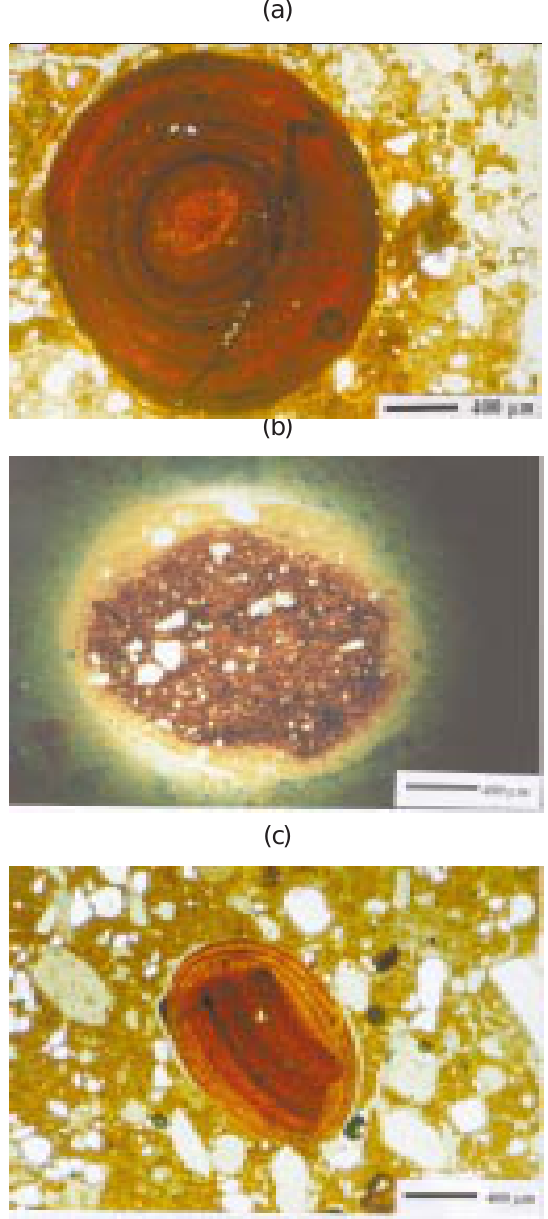
Figura 4. Concreção observada no horizonte BC2 do Cambissolo. Observa-se o aporte de ferro ao redor da estrutura (A), nódulo sesquioxídico do Bi3 do Cambissolo, onde se observam diferentes graus de hidratação dos óxidos de ferro (B), concreção ferro-manganosa da camada de 15-30 cm de um Latossolo Vermelho. Observa-se que a estrutura é constituída por fragmento de concreção recapeado por concentrações Fe/Mn posteriores (C).